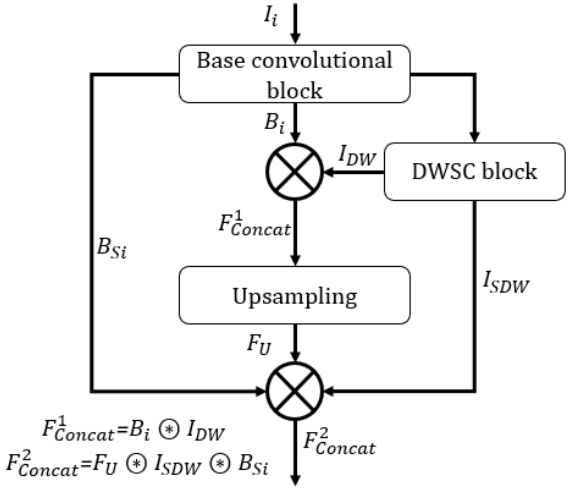
Figure 4. Connectivity of proposed